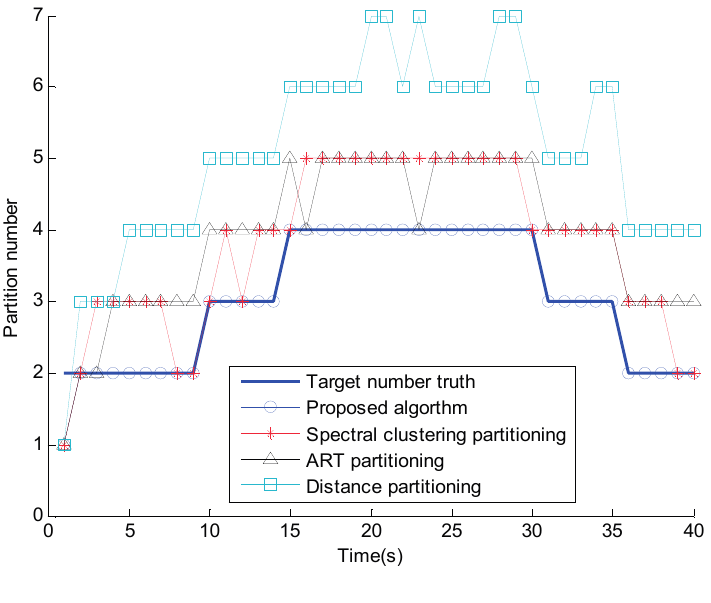
Figure 6. Partition